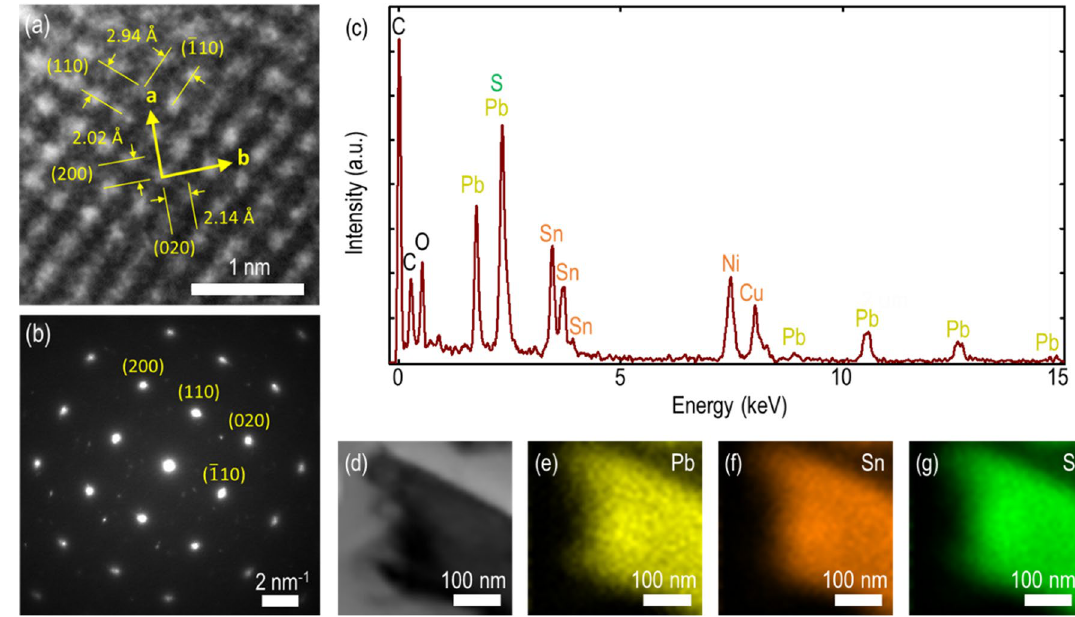
Figure 2. ( a ) Representative atomic HRTEM image of a thin teallite crystal. ( b ) The corresponding SAED pattern. ( c ) Recorded average EDXS spectrum. Three prime elements (Pb, Sn and S) as per their atomic weight percentage are considered for determining the chemical composition of teallite crystal. ( d ) Bright-field TEM image of the scanned region. ( e – g ) TEM-EDXS mapping of individual elements, emphasizing the consistency and presence of lead, tin, and sulfur in the probed teallite crystal.